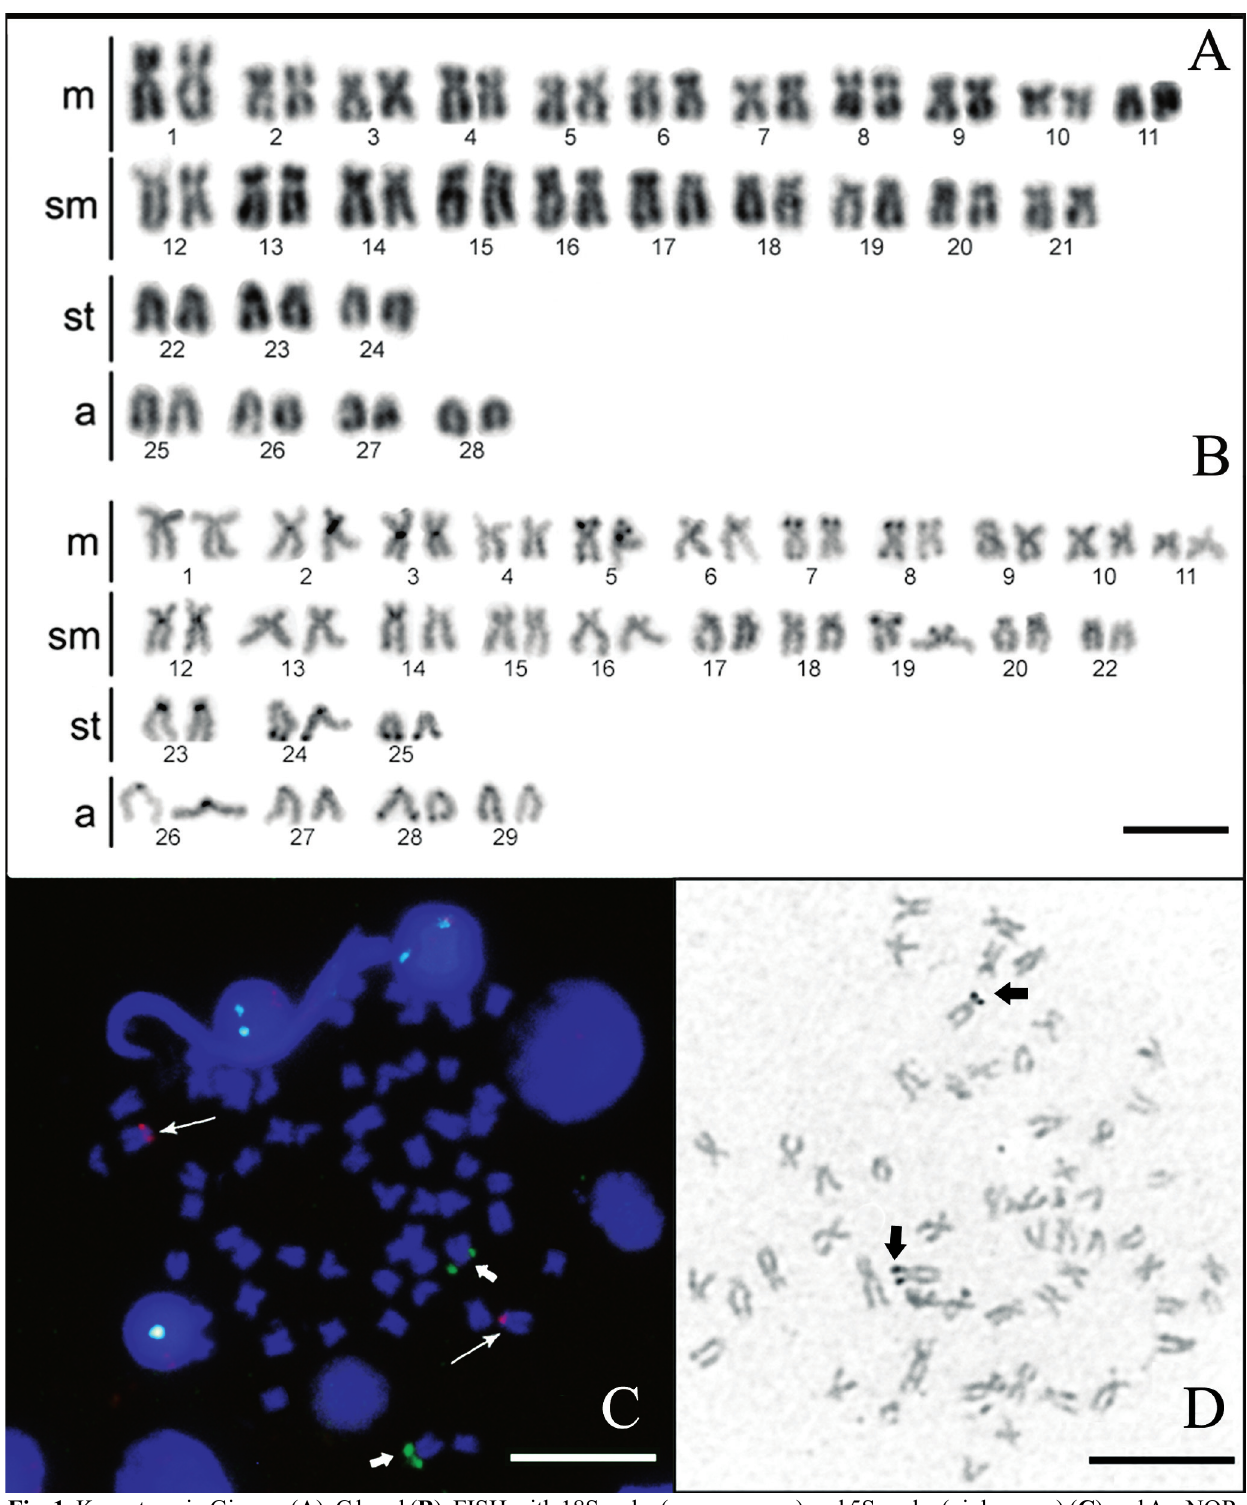
Fig. 1. Karyotype in Giemsa ( A ), C band ( B ), FISH with 18Sprobe (green arrows) and 5S probe (pink arrow) ( C ) and Ag-NORs ( D ) in Pseudoplatystoma reticulatum from the rio Paraguay (MS). m = metacentric; sm = submetacentric; st = subtelocentric; a = acrocentric. Scale bars = 10 μ